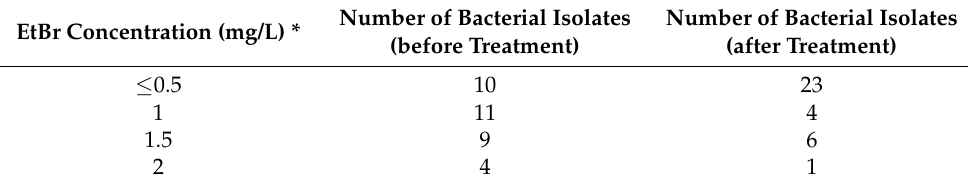
Table 1. Efflux pump activity before and after treatment with C. thouarsii extract at different concen- trations of EtBr using the cartwheel method.